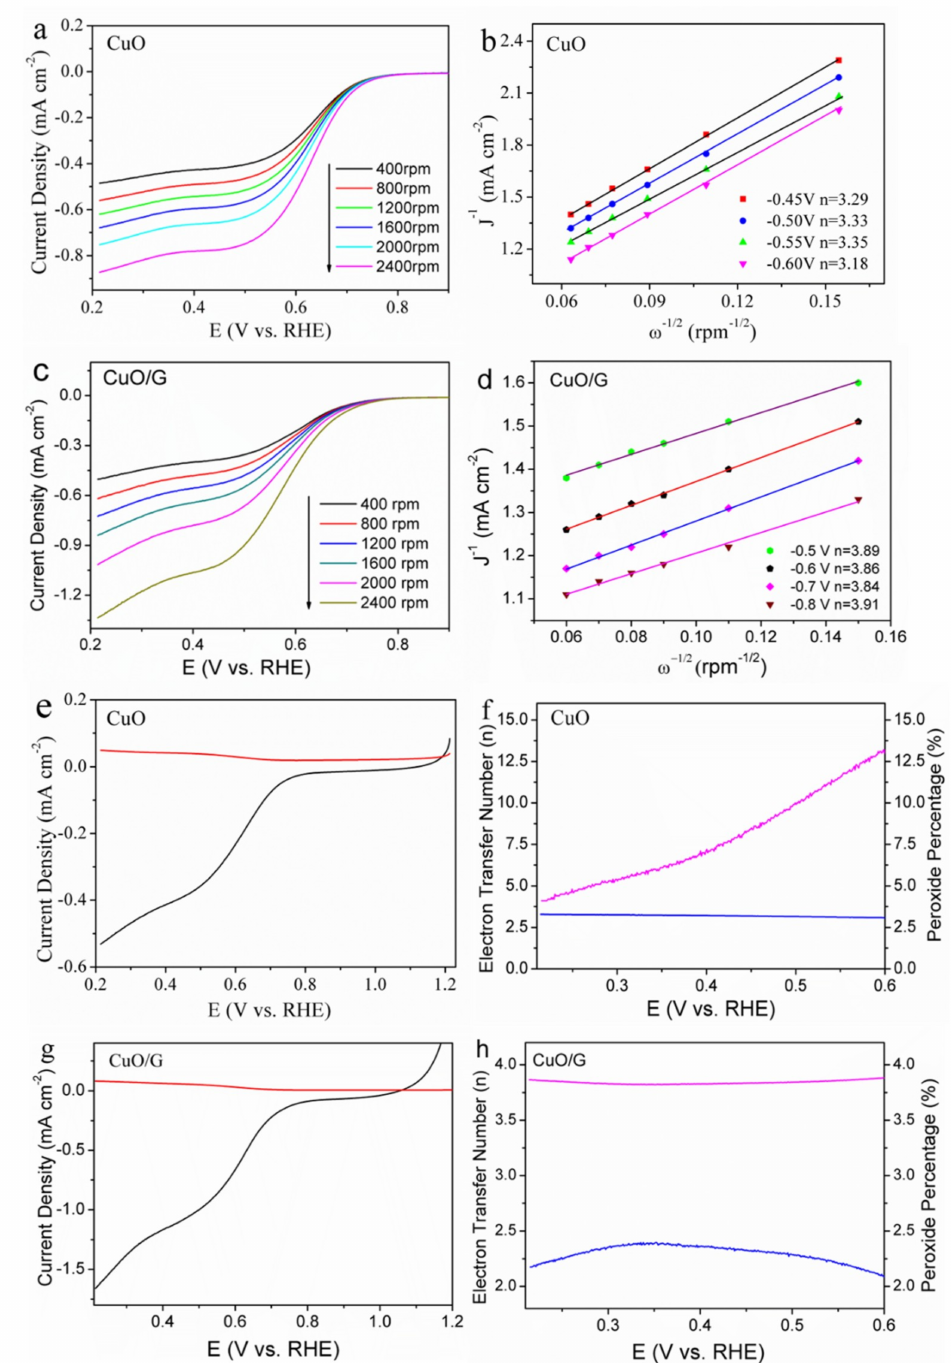
Figure 4. Investigating of ORR mechanism on catalysts: ( a and c ) rotating disk LSV profiles of CuO and CuO/G, respectively in O 2 -saturated 0.1 M KOH solution at various rotation rates ranging from 400 to 2400 rpm along with ( b and d ) their corresponding Koutecky-Levich plots at different potentials. Rotating ring disk electrode (RRDE) LSV profiles ( e and g ) on CuO and CuO/G at a rotation rate of 1600 rpm along with their percentage of peroxides and the electron transfer number ( f and h ), scan rate: 5